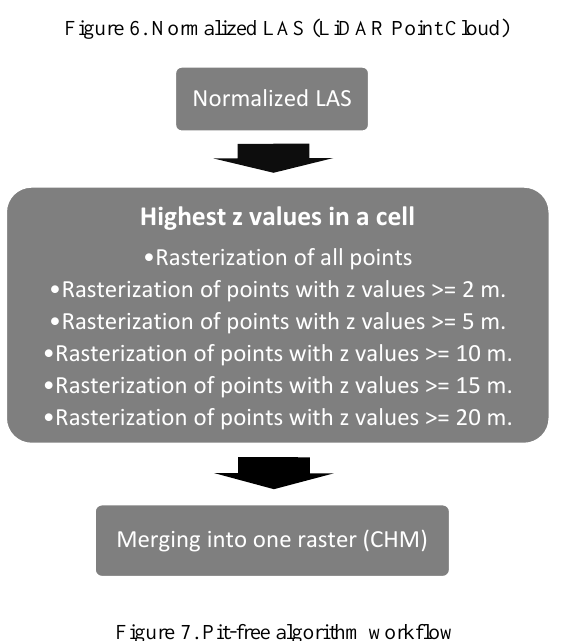
Figure 7. Pit-free algorithm workflow